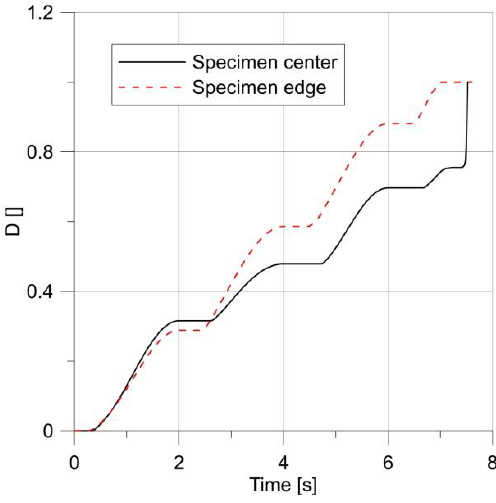
Figure 16. Changes in parameter D under load.